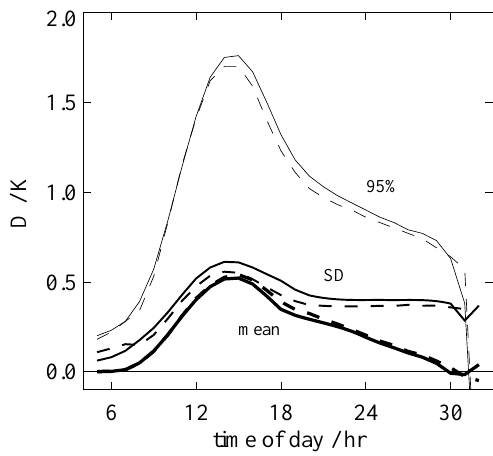
Fig. 7. Statistics of diurnal warming D averaged over the SE- VIRI area (55 ◦ W–45 ◦ E, 50 ◦ S–50 ◦ N) during June 2006–May 2007, comparing model predictions and SEVIRI observations of the mean, standard deviation, and 95-percentile. Solid lines are the observed warming, dashed lines are the modelled warming. The model standard deviation and 95-percentile curves are for the model plus the background variability. The 95-percentile curves are from cases with positive integrated net heat flux